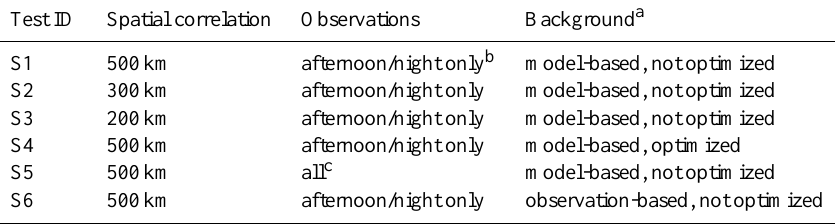
Table 5. Overview of the sensitivity tests.